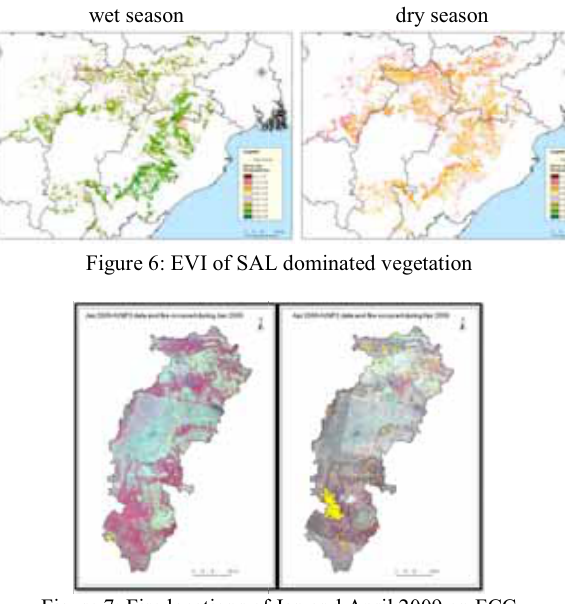
Figure 7: Fire locations